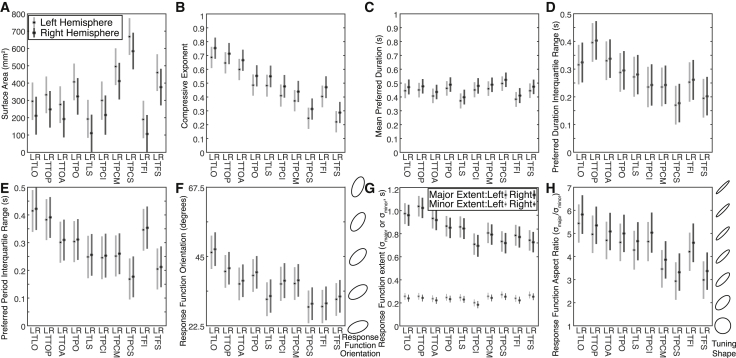
Differences between Timing Maps(A) Left-hemisphere maps have larger surface areas than right-hemisphere maps, and map surface areas increase from inferior to superior maps.(B) The compressive event frequency exponent decreases from posterior to anterior maps, from inferior to superior along the postcentral (TPCI-TPCS) and precentral (TFI-TFS) sulci, and in the left hemisphere.(C) The mean preferred duration of recording sites differed little between maps.(D and E) The interquartile range of preferred durations (D) and periods (E) of each map’s recording sites decreases from posterior to anterior.(F) Response function orientation becomes more horizontal from posterior to anterior.(G) The response function major extent (timing range to which individual recording sites respond) decreases from posterior to anterior. The minor extent does not change.(H) The mean response function aspect ratio (i.e., extent of response function elongation) therefore decreases from posterior to anterior.Points represent the population marginal mean of values across subjects. Error bars are 95% confidence intervals: separable error bars show significant differences at p < 0.05.